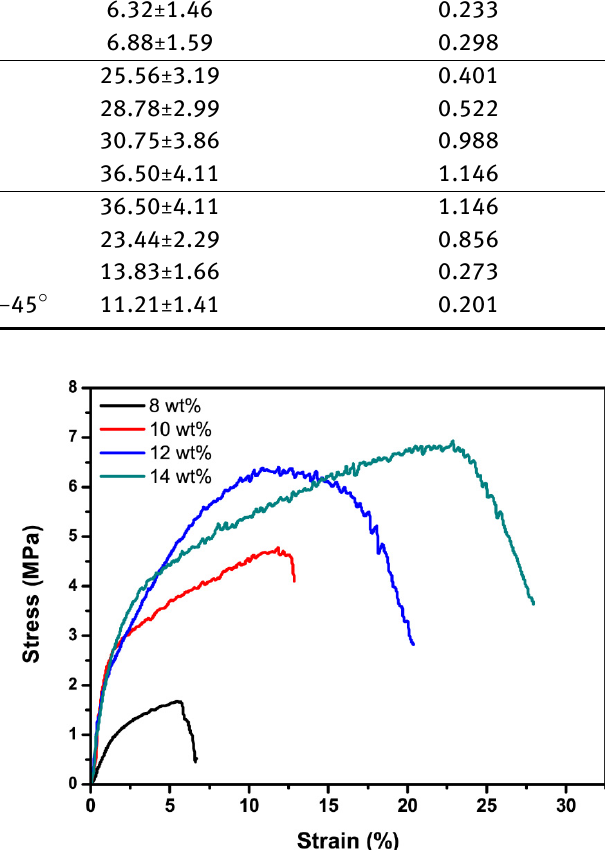
Table 1: Mechanical properties of PAN nanofiber membranes with different parameters. Membranes Parameters Random membranes with different